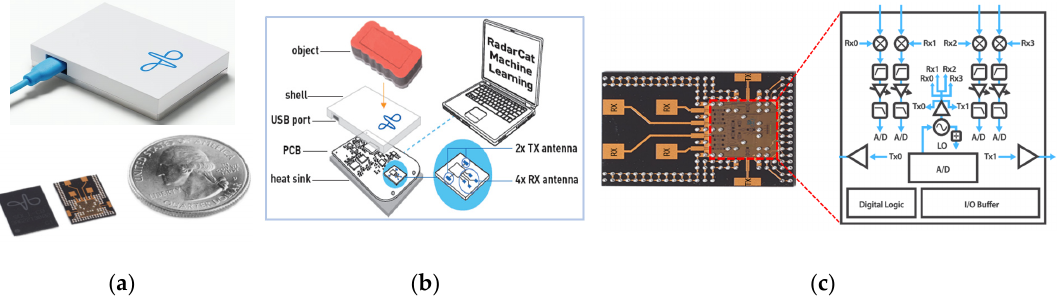
Figure 4. Soli FMCW radar system: ( a ) Radar integrated system in package and 8mm X 10 mm radar transceiver chip; ( b ) Soli connection with PC for simple experimental setup for object identification; ( c ) The radar chip with antennas-in-chip, Tx/Rx positions and hardware architecture (adapted from [57]).